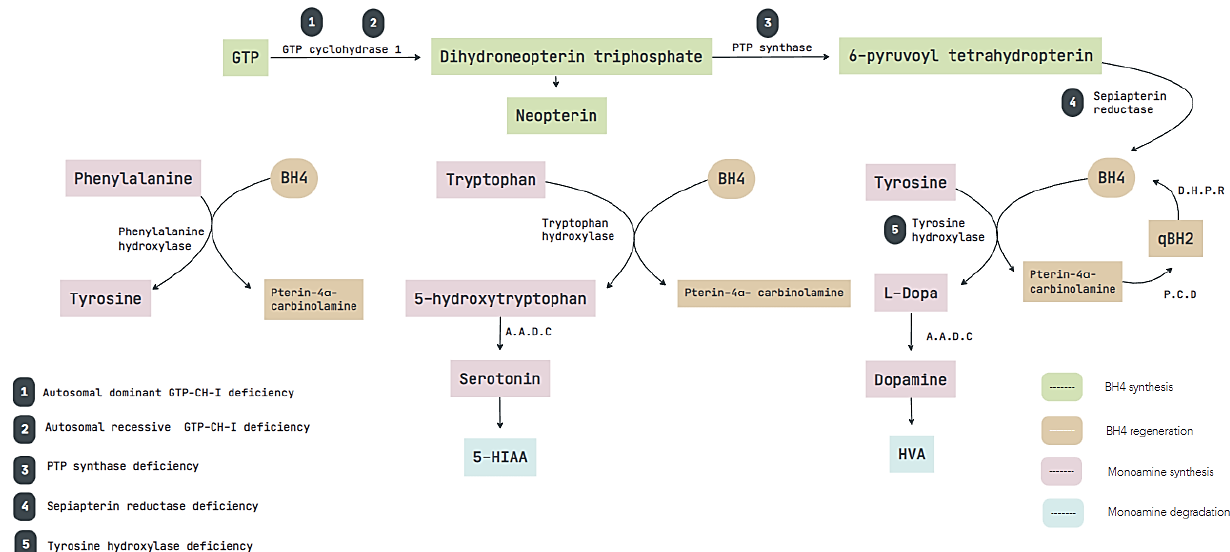
Figure 1. Affected enzymes and phenotypes of DRD. Biosynthesis of BH4 and monoamine neuro- transmitters. Abbreviations: AADC, aromatic l-amino acid decarboxylase; BH4, tetrahydrobiopterin; DHPR, dihydropyridine reductase; HVA, homovanillic acid; 5-HIAA, 5-hydroxy indole acetic acid; PCD, pterin-4- α -carbinolamine; PTP, 6-pyruvoyl tetrahydrobiopterin; qBH2, quinonoid dihydrobiopterin.